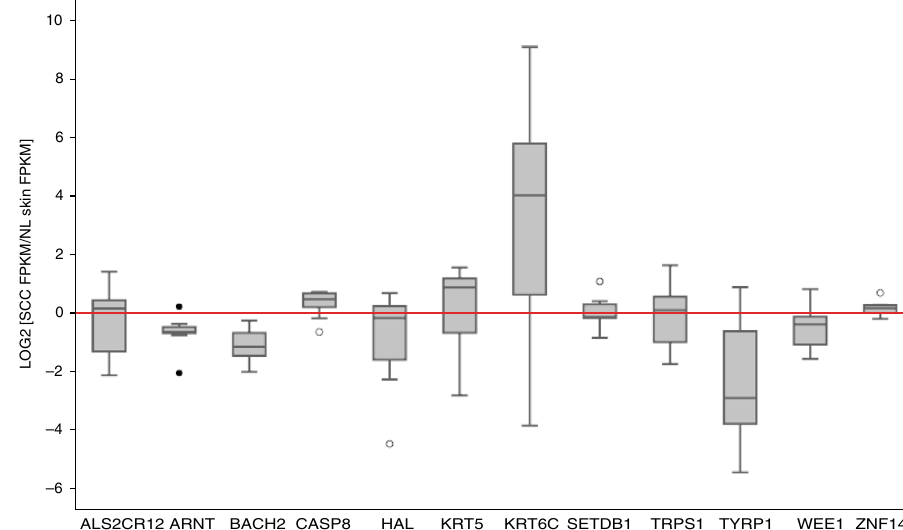
Fig. 2 Gene expression analysis for novel SCC susceptibility loci. RNA-seq data were obtained from Gene Expression Omnibus (GSE84194) were analyzed by DESeq. Transcript levels (FPKM) in SCC samples were compared with levels in paired matched normal skin. Boxplot demonstrates log 2 [SCC/ Normal skin] expression levels for 13 genes surrounding the novel SNPs. Legend for box and whisker plots. The black center line denotes the median value (50th percentile), while the gray box contains the 25th to 75th percentiles of data set. The black whiskers mark the 5th and 95th percentiles, and values beyond these upper and lower bounds are considered outliers, marked with white circles. The red threshold line indicates the point where these is no change in gene expression between SCC tumor and normal skin. ARNT, BACH2 , TYRP1, and WEE1 were signi fi cantly downregulated in SCC as compared with normal skin and CASP8 and KRT6C were upregulated in SCC relative to normal skin by